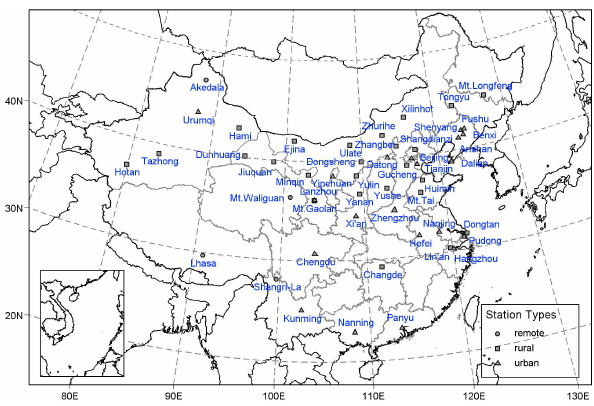
Figure 1. Locations of the 50 CARSNET sites in